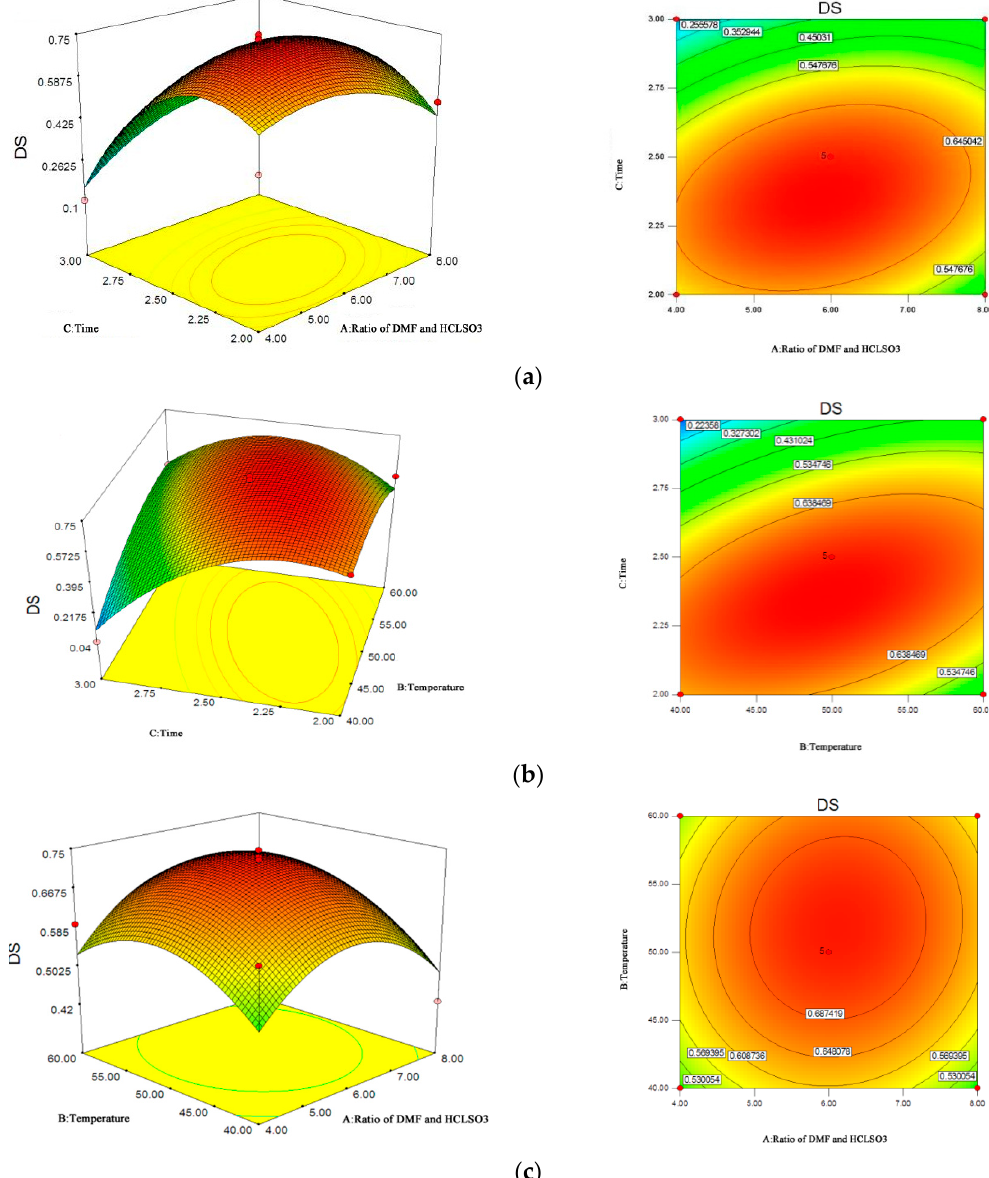
Figure 1. Response surface plots. ( a ) Effect of the ratio of DMF ( N , N -dimethyl formamide) and HClSO 3 and reaction time on DS of SYG; ( b ) Effect of reaction temperature and reaction time on content of DS of SYG; ( c ) Effect of reaction temperature and ratio of DMF and HClSO 3 on DS of SYG.